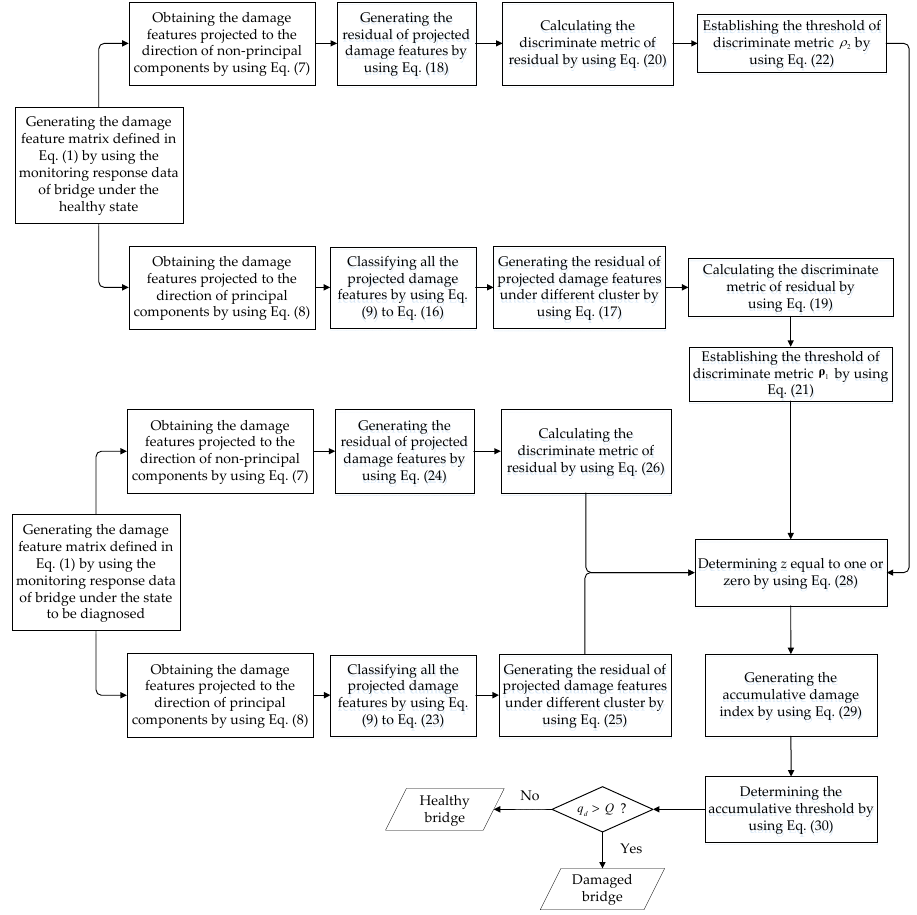
Figure 2. Diagram of the proposed hybrid method for detecting the damage of